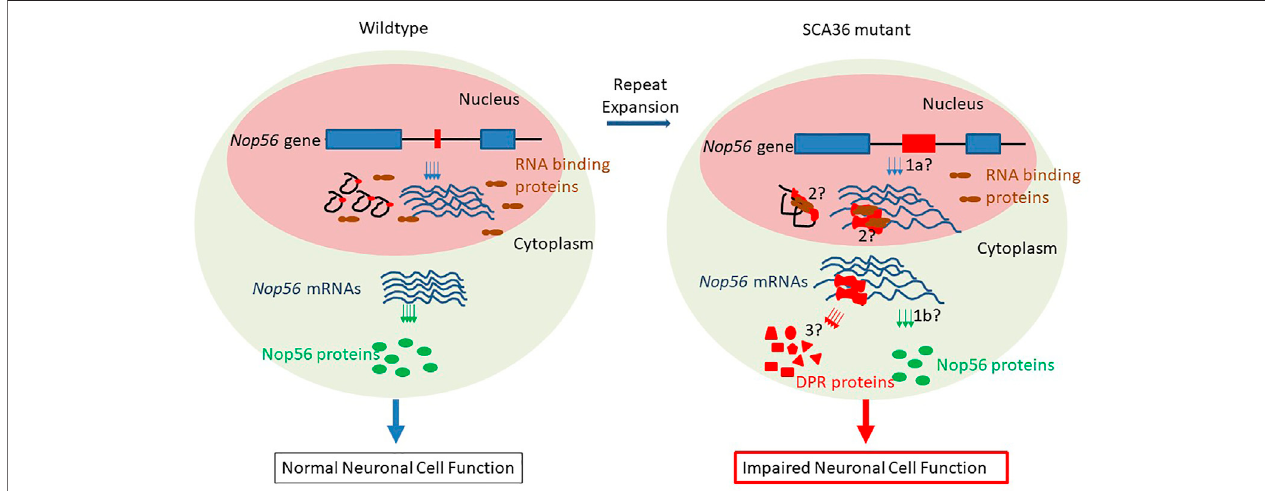
FIGURE 2 | Possible mechanisms of pathogenesis in SCA36. Left panel (normal condition): in the nucleus, the short repeat-containing wild-type Nop56 genes (exon 1 and exon 2 in blue boxes, black solid line as introns, and GGCCTG repeats in red boxes) are transcribed into mature mRNAs (blue lines), and the repeat- containingintronssplicedoutaslariats(inblack),otherRNA-bindingproteins (inbrown)arescatteredinthenucleus; incytoplasm, Nop56 maturemRNAsaretranslated to normal amount Nop56 proteins (green ovals) and neurons are functioning normally. Right panel (SCA36 condition): in nucleus, the mutant Nop56 gene with expanded GGCCTG repeats (in red box) could betranscribed at different amounts (haploinsuf fi ciency mechanism/1a), and theexpandedGGCCUGrepeat RNA (in red) could be either present as lariats or retained in mRNAs to sequester other RNA-binding proteins (RNA gain-of-function mechanism/2); in the cytoplasm, the expanded GGCCUG repeat-containing Nop56 mRNAs could either impede the production of NOP56 proteins (haploinsuf fi ciency mechanism/1b) or undergo unconventional translation (RAN translation mechanism/3) into dipeptide repeat (DPR) proteins (red triangle, rectangle, circle, pentagon, and trapezoid). These possible mechanisms result in the impaired neuron functions